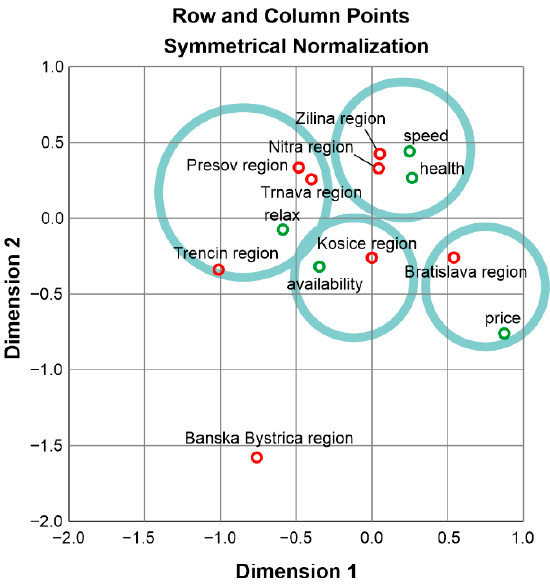
Figure 5. Correspondence map II.